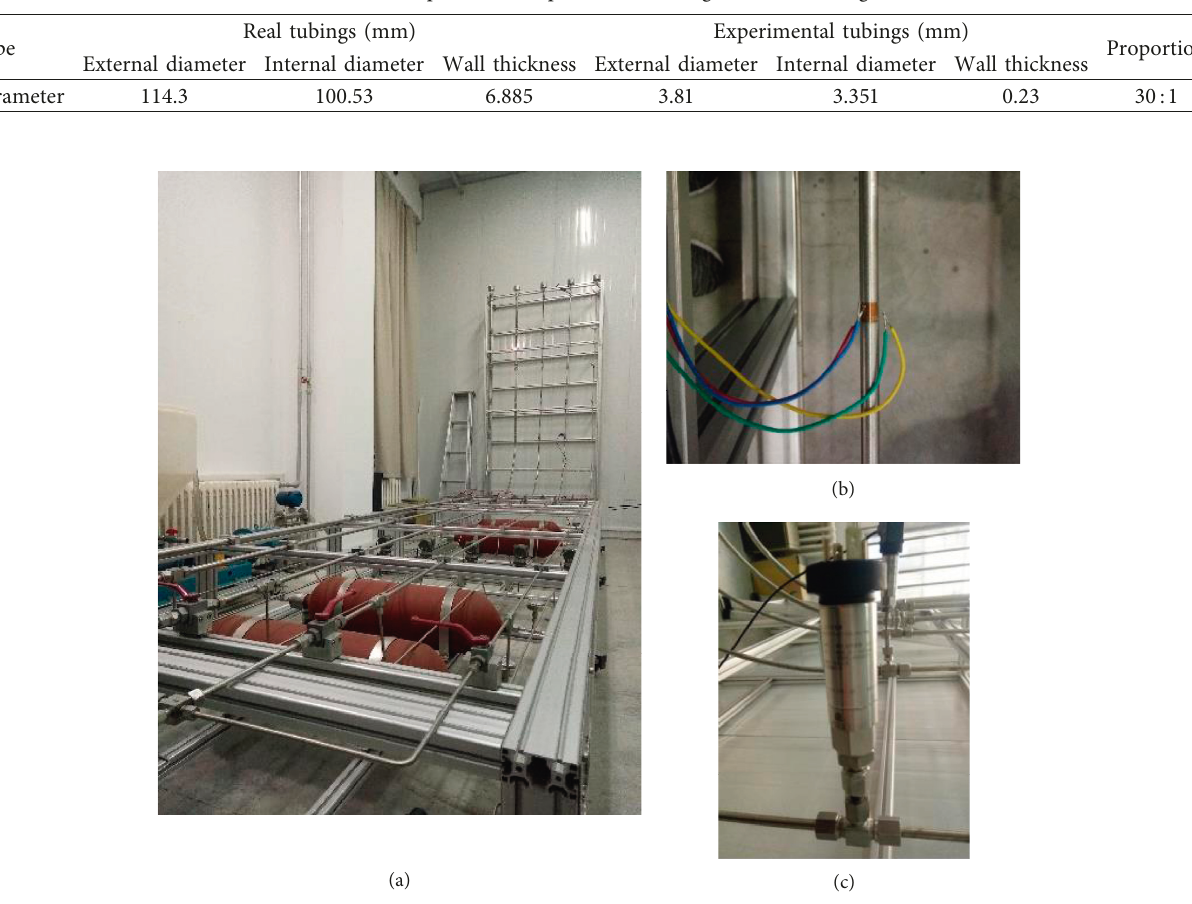
Table 3: Comparison of experimental tubings and real tubings.